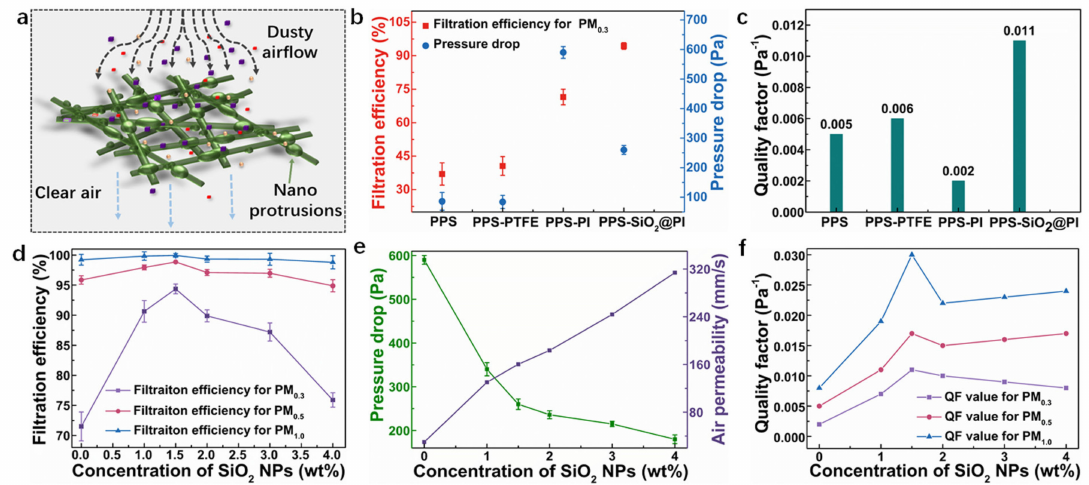
Figure 8. ( a ) The schematic diagram of air filtration through polyphenylene sulfide (PPS)–SiO 2 @PI composite filters; filtration performance ( b ) and quality factor (QF) values ( c ) of di ff erent kinds of PPS filters; filtration e ffi ciency ( d ), pressure drop and air permeability ( e ), and QF values ( f ) of relevant PPS–SiO 2 @PI composite filters for PM 0.3 , PM 0.5 , and PM 1.0